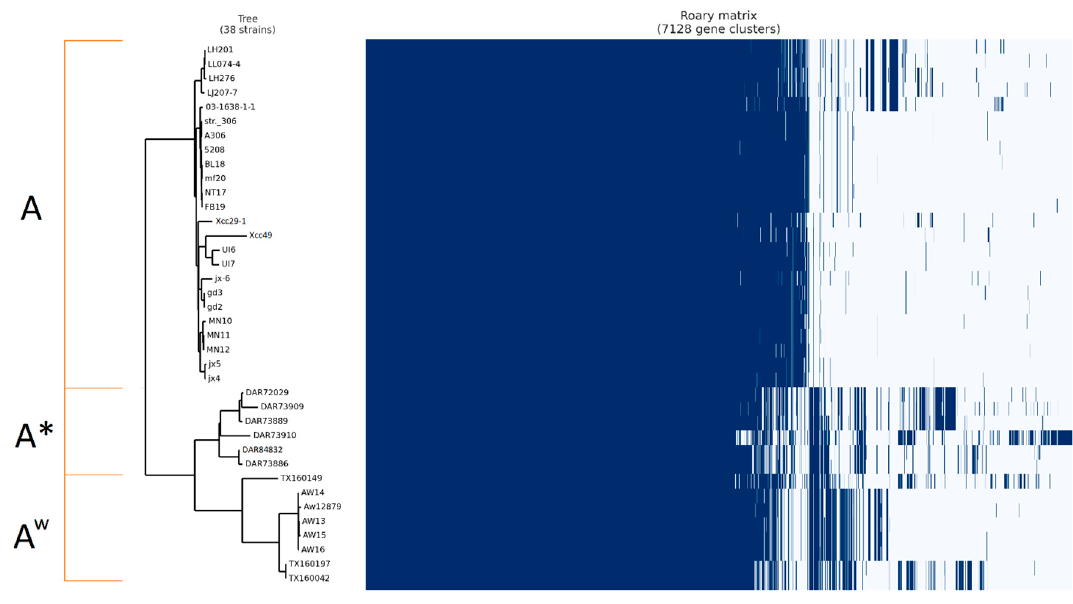
Figure 2. Roary pan-genome matrix of Xanthomonas citri pv. citri A, A*, and Aw pathotypes of sequenced and reference isolates. Figure produced using presence/absence pangenome matrix and Snippy core alignment filtered with gubbins. Blue bars represent genes present in the genome.